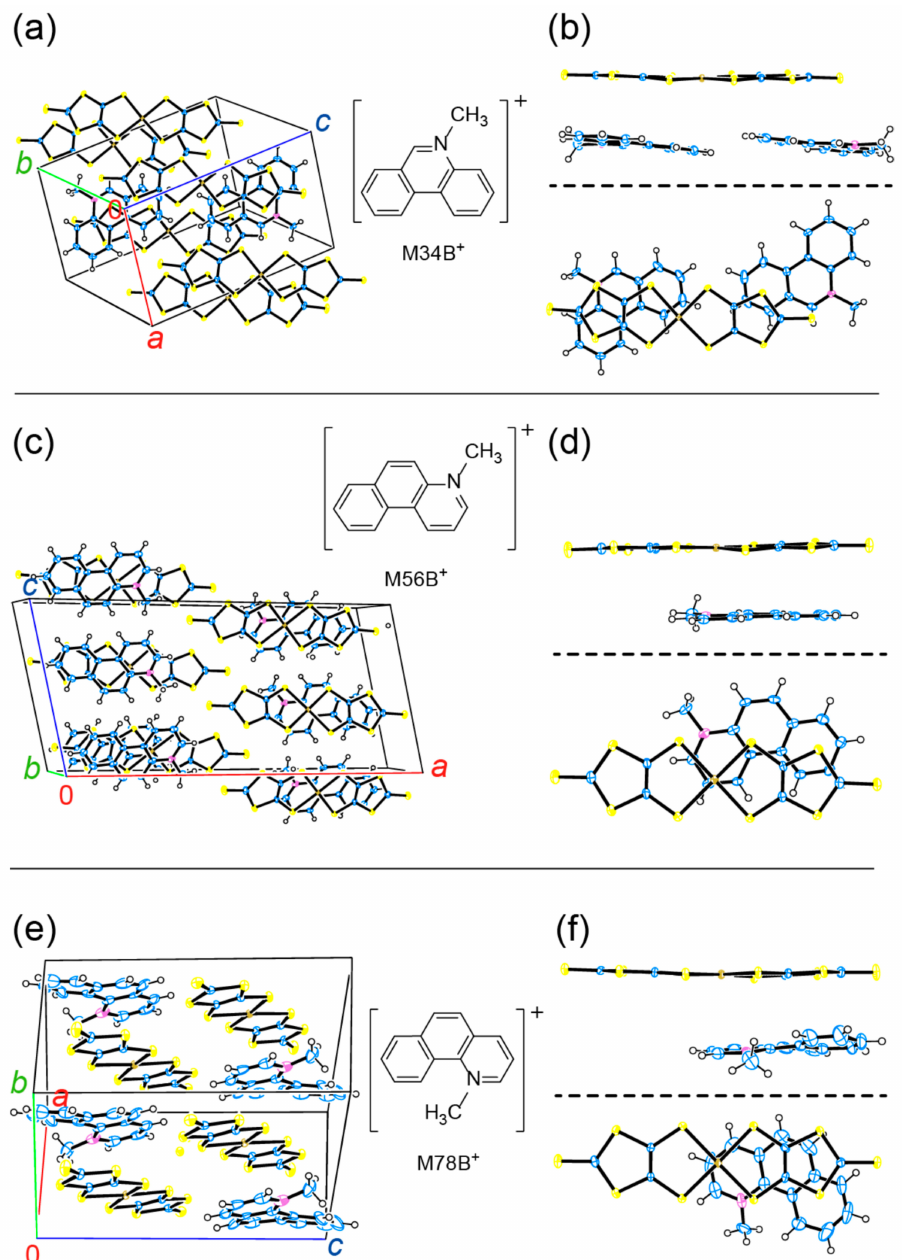
Figure 19. Typical molecular arrangements of anions and cations in MXB[Au(dmit) 2 ]. For MXB + , see Figure 18. ( a , b ) X = 34; ( c , d ) X = 56; ( e , f ) X = 78. Blue, purple, blank, yellow, and brown spheres designate C, N, H, S, and Au atoms, respectively. Reproduced and modified from Ref. [95] with permission from the Chemical Society of